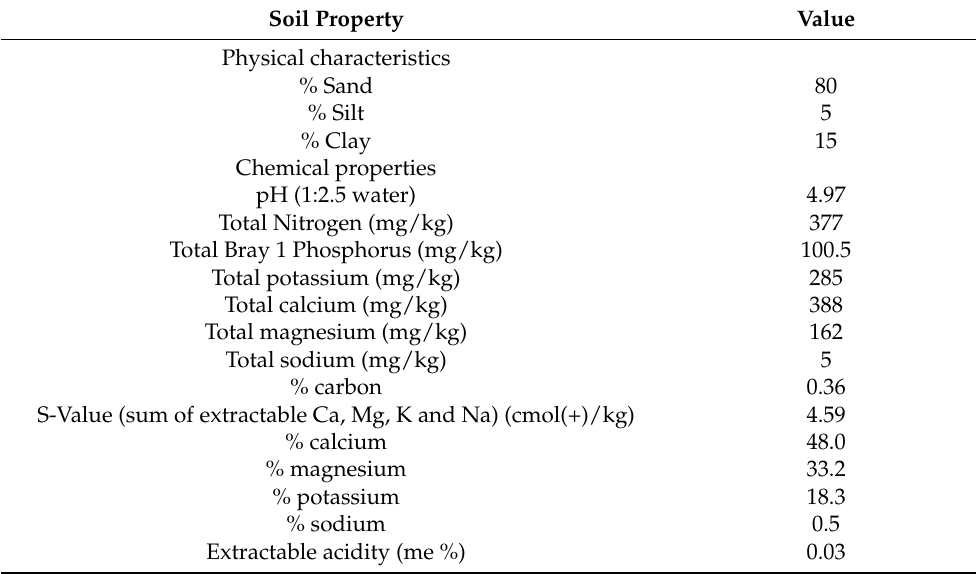
Table 1. Physicochemical properties of the soil prior to planting, and fertilization. Soil Property